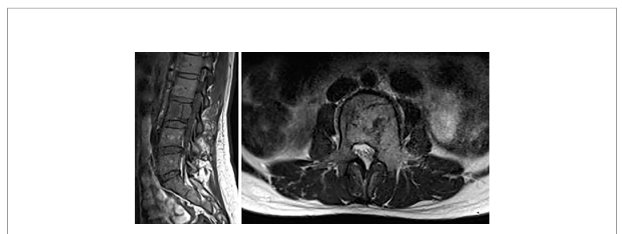
FIGURE 1 | Primary spinal epithelioid hemangioendothelioma (EHE) in a 25- year-old woman. A sagittal image of the lumbar spine reveals the abnormal shape of lumbar 3 vertebral body with a mass in the vertebral body and accessories. MRI showed an inhomogeneous low signal on T 1 -weighted image (T 1 WI) and a high signal on T 2 WI with punctate low-signal foci and accompanying normal discs.